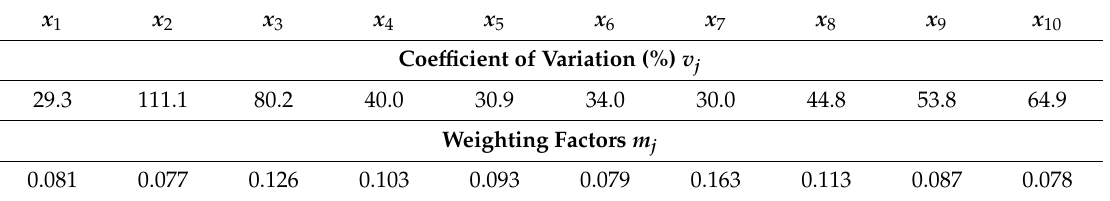
Table 2. The level of variability and weighting factors assigned to individual indicators.